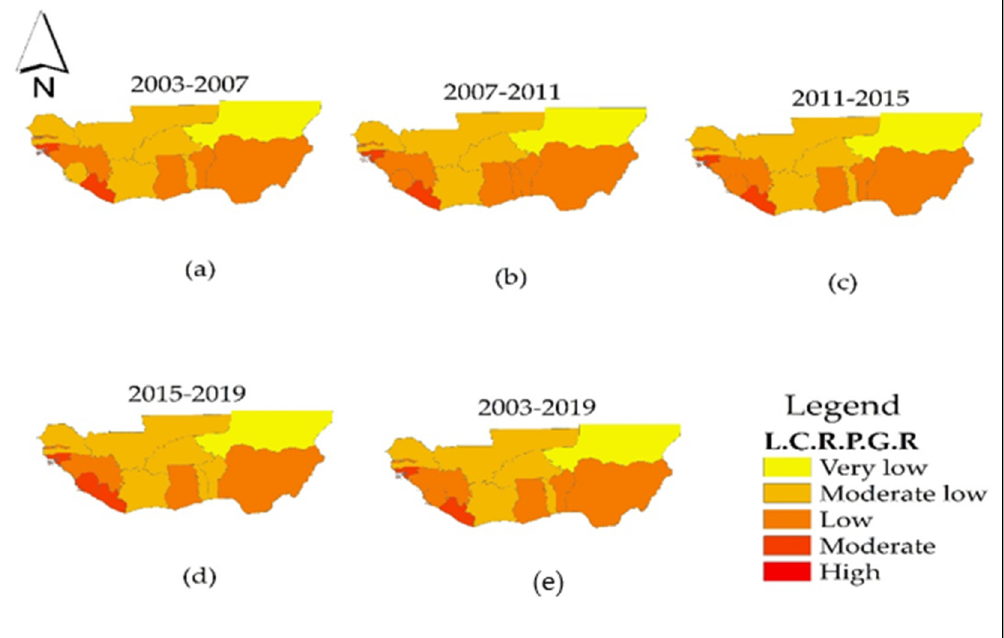
Figure 4. ( a – d ) shows the consumption land rate to population urban growth rate (LCRPGR) in 2003–2007, 2007–2011, 2011–2015, and 2015–2019, respectively, and ( e ) shows the study period of